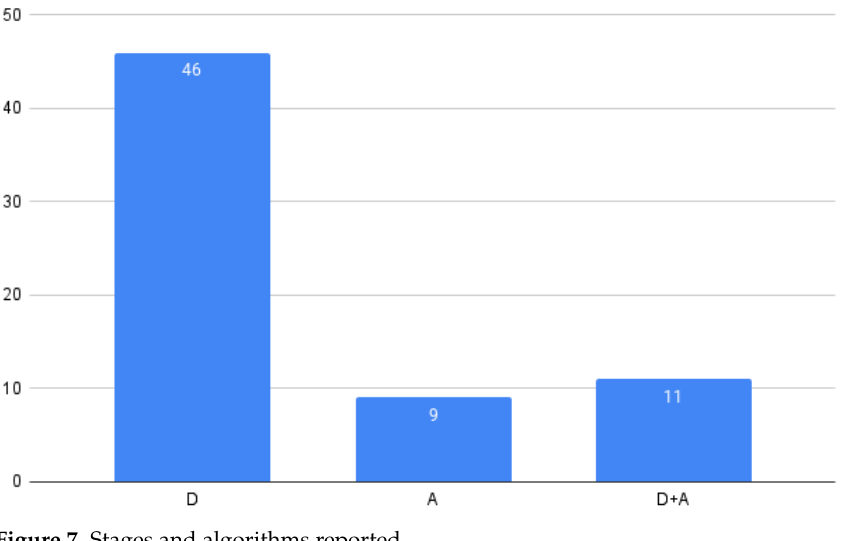
Figure 7. Stages and algorithms